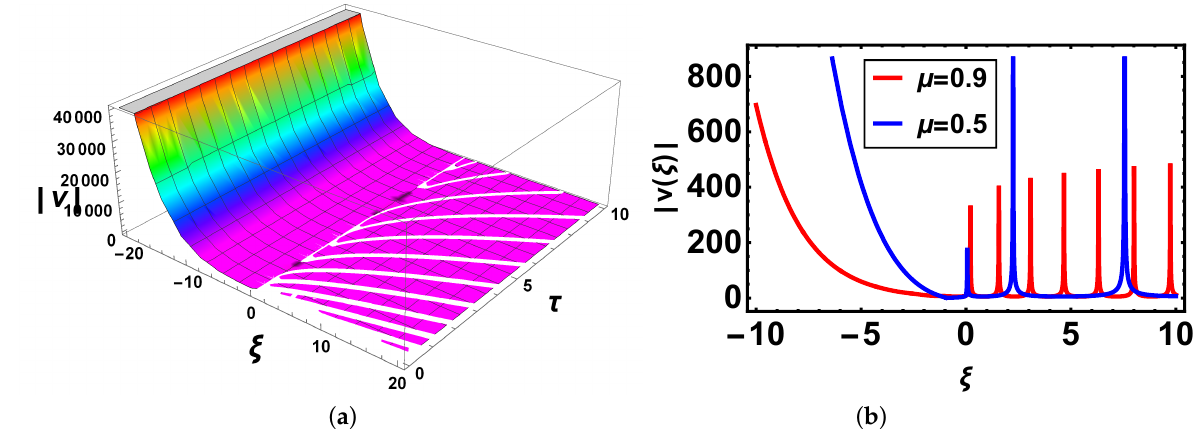
Figure 6. ( a ) 3D and ( b ) 2D plots with same parameter values as above µ = 0.5 and Θ = 1.1 of v 25 ( ξ , τ ) with the M-truncated